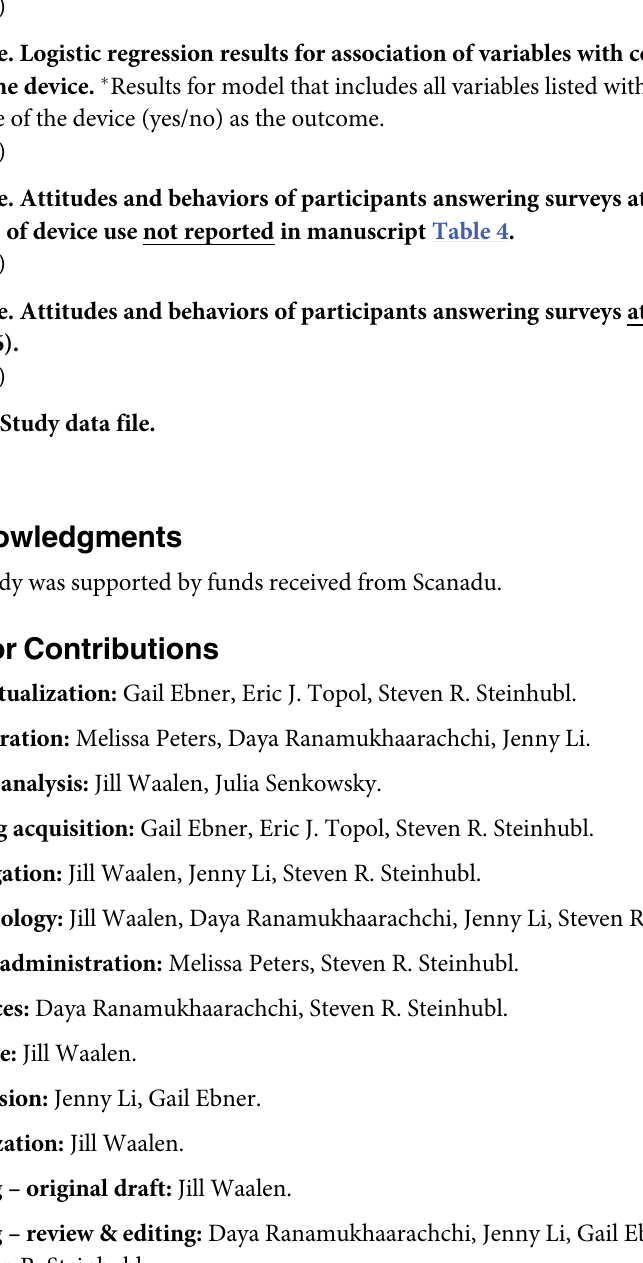
S1 Table. Baseline characteristics not reported in manuscript Table 1. � Chi square test (DOCX) S2 Table. Patterns of device use by number of weeks in the study. � Chi square test S3 Table. Logistic regression results for association of variables with consistent long-term use of the device. � Results for model that includes all variables listed with consistent long- term use of the device (yes/no) as the outcome. S4 Table. Attitudes and behaviors of participants answering surveys at 12 months by amount of device use not reported in manuscript Table 4. S5 Table. Attitudes and behaviors of participants answering surveys at all time points (n =